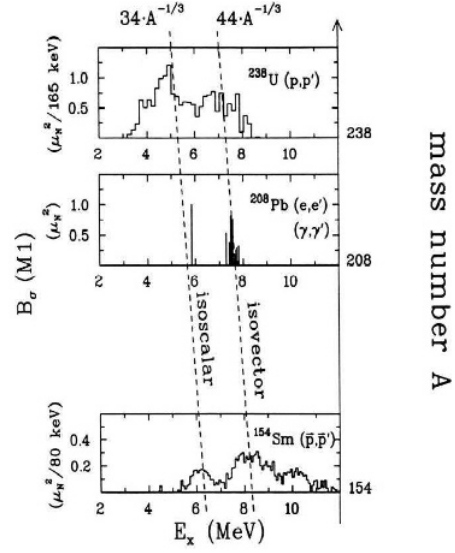
Fig. 1. Systematics of the spin- M 1 resonance in heavy deformed nuclei measured at TRIUMF [3].